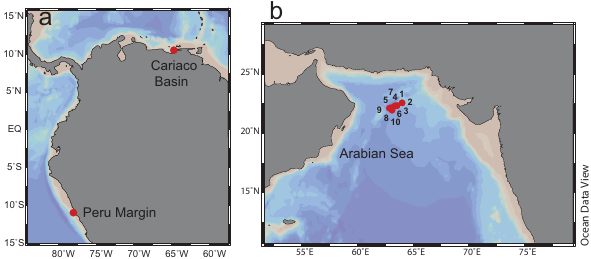
Fig. 2. Location of sampling sites. Red circles correspond to a deep sediment core (185.6 mb.s.f.) in the Peru Margin (ODP Leg 201 – Site 1229), a water column particulate matter depth profile in the Cariaco Basin (aboard the R/V Paraguachoa ) and a series of surface sediments in the Arabian Sea (aboard R/V Pelagia cruise 64PE301). The Arabian particulate water column site is Station 10. Surface sediments were taken at Stations 1 through 10, located along Mur- ray Ridge, while sediment cores of up to 32cmb.s.f. depth were taken at Stations 1, 4, and